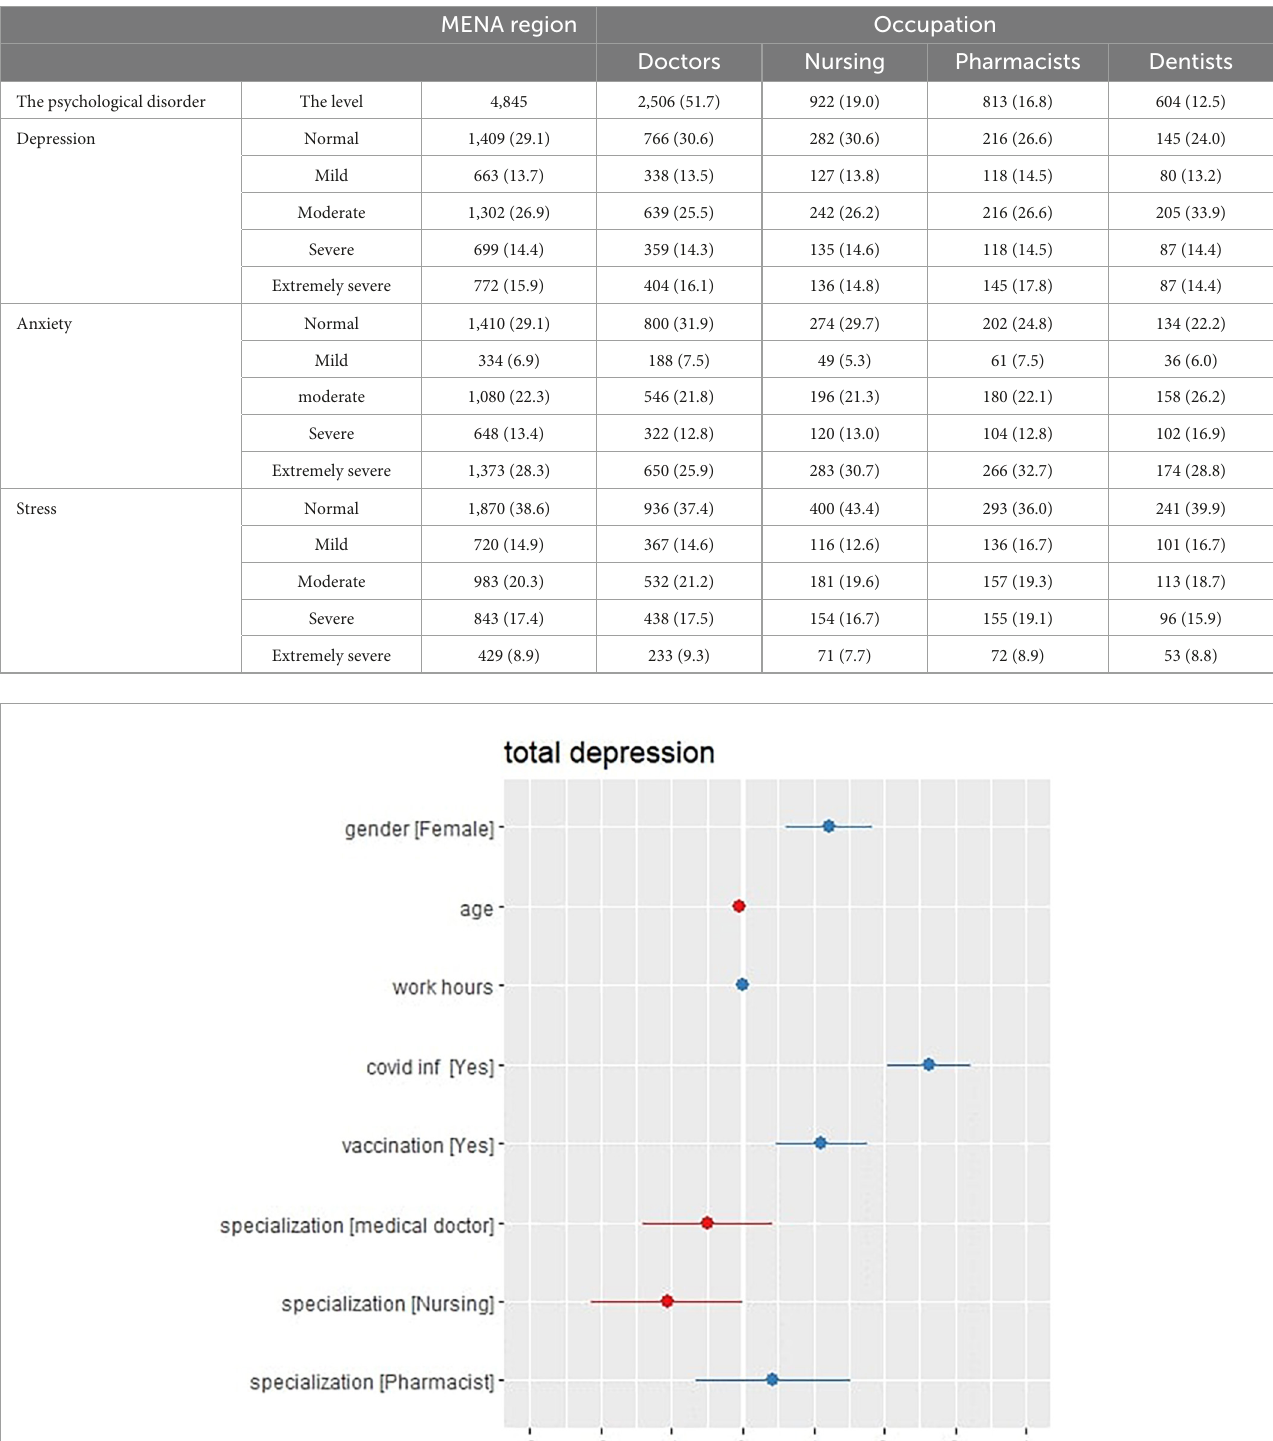
TABLE 3 Psychological state per occupation.